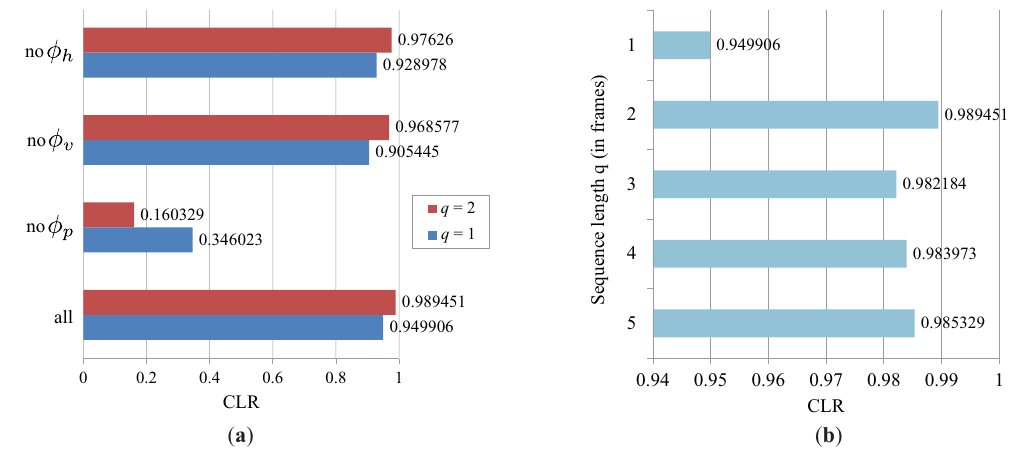
Figure 15. Results obtained on the outdoor dataset: ( a ) the results illustrate the importance of the selected structure of the PGM and ( b ) the impact of the sequence length on the correct labeling rate